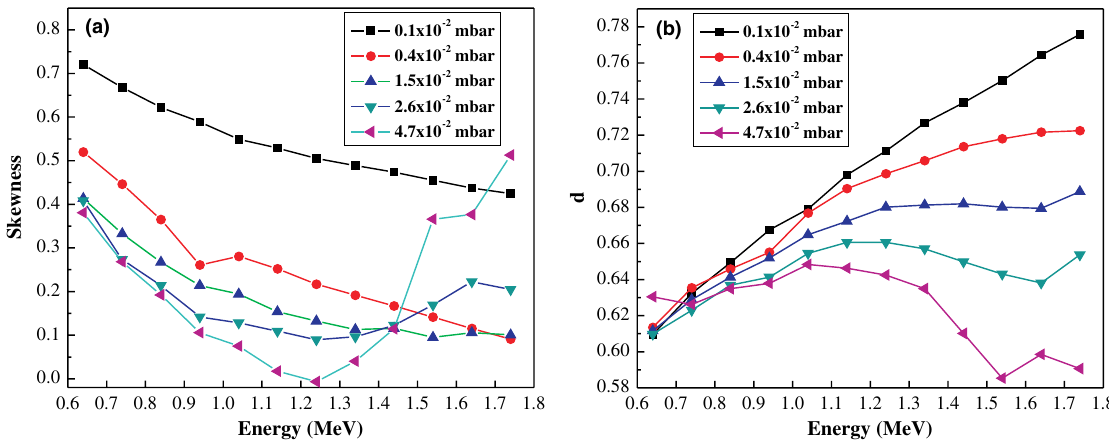
FIG. 7. (a) Variation of skewness of the charge state distribution with the incident ion energy at different stripper gas pressures. (b) Variation of the width of charge state distribution with the incident ion energy at different stripper gas pressures.